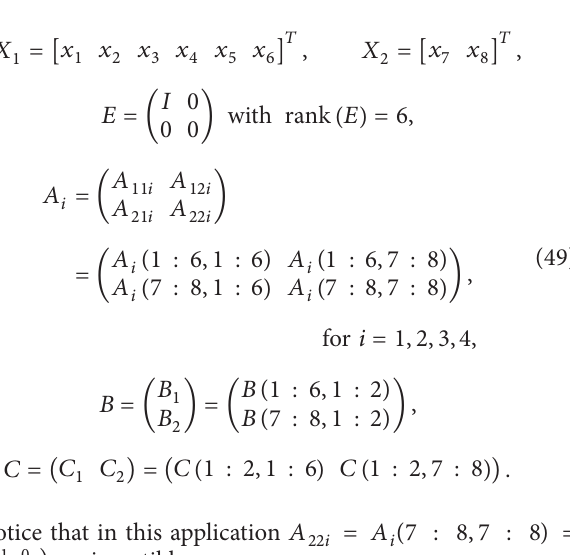
Table 1: List of